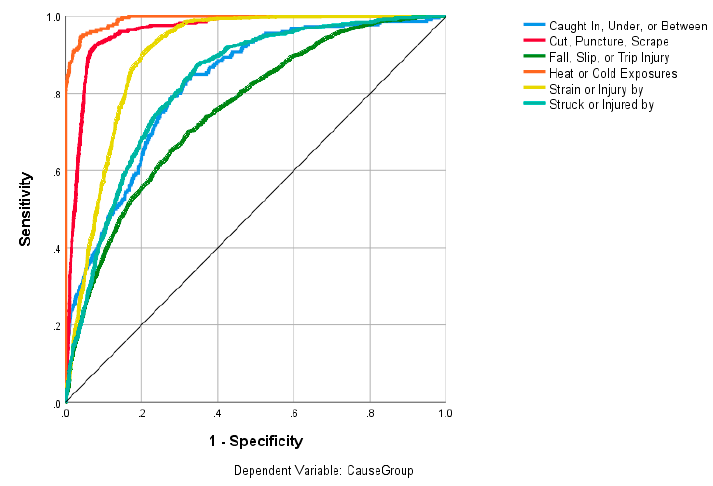
Figure 5. Receiving operating charts (ROC) for MLP Model (Test Data).